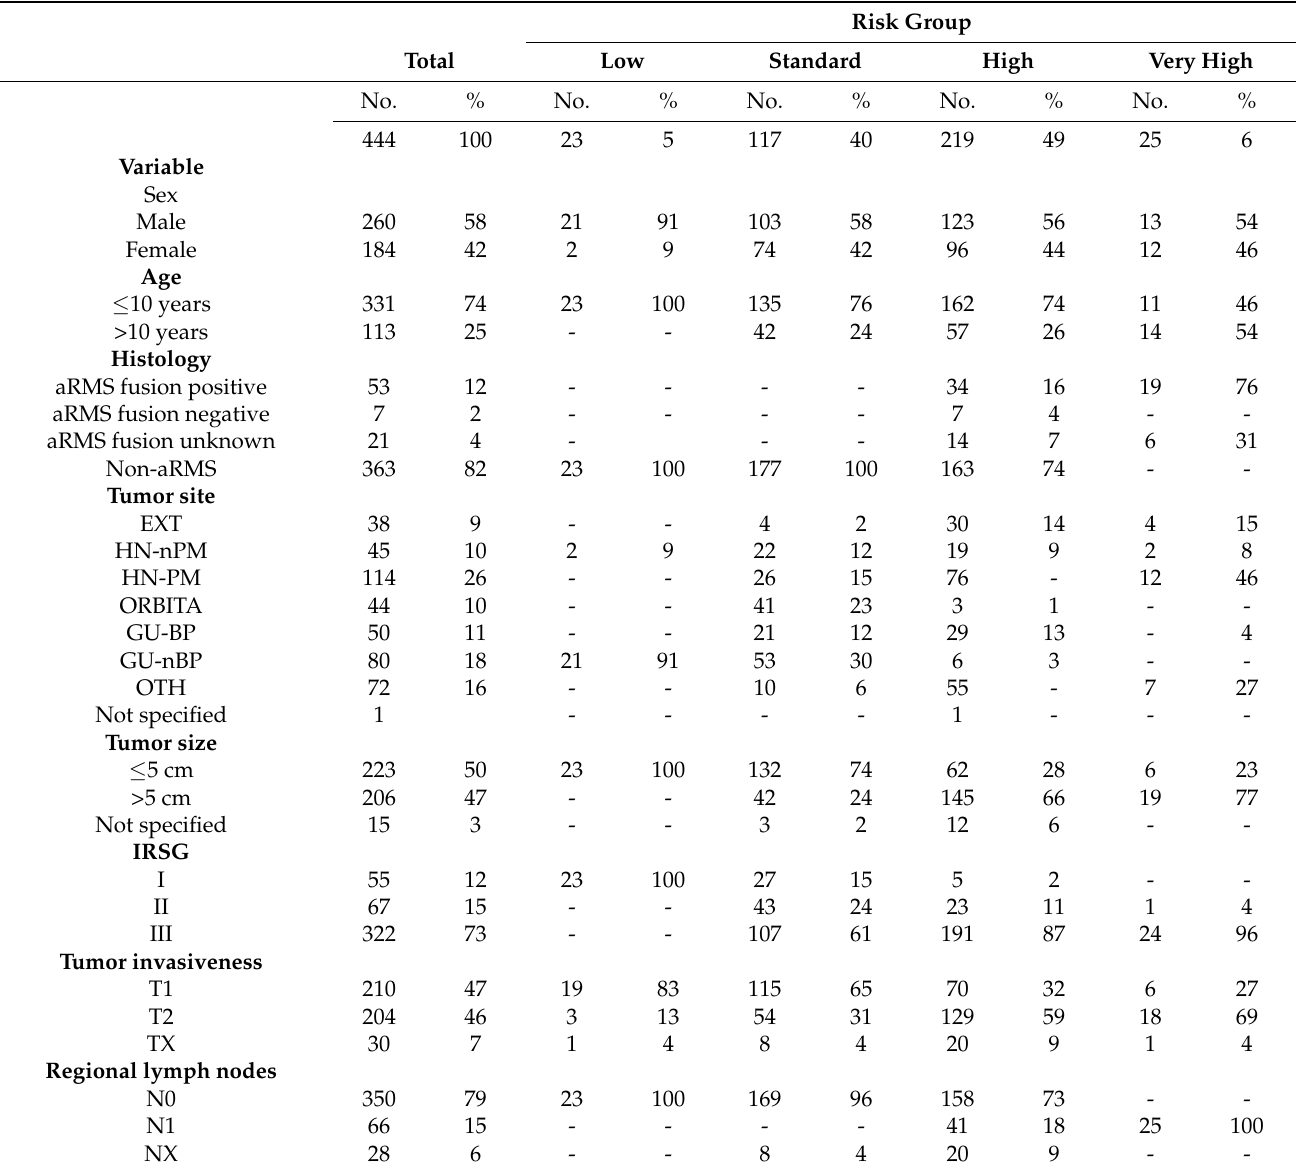
Table 2. Patient